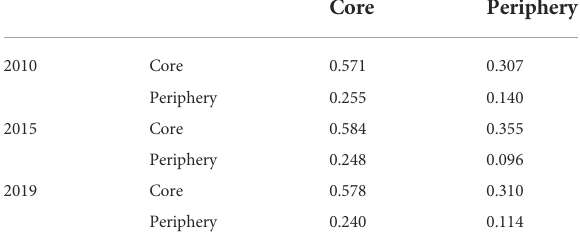
TABLE 4 Density of core and peripheral regions.